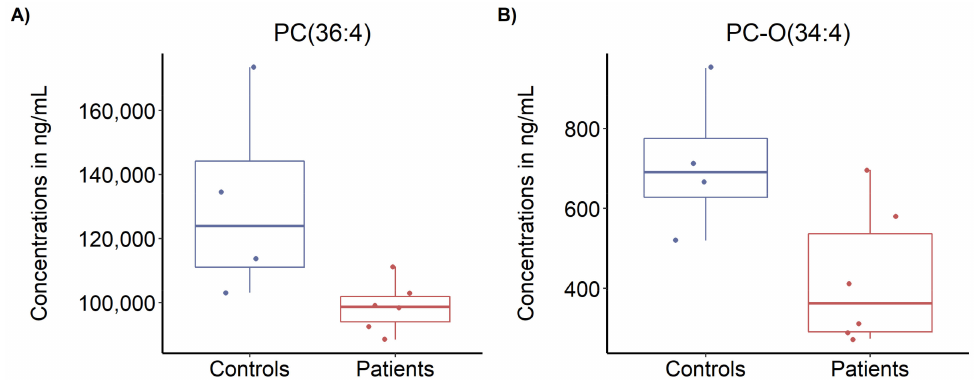
Figure 5. Targeted metabolomics profiling. ( A ) Levels of PC(36:4), and ( B ) levels of PC-O(34:4) in plasma from ME/CFS patients and controls. Blue bar, control; red bar, ME/CFS patients. n = 10 (4 controls, 6 ME/CFS